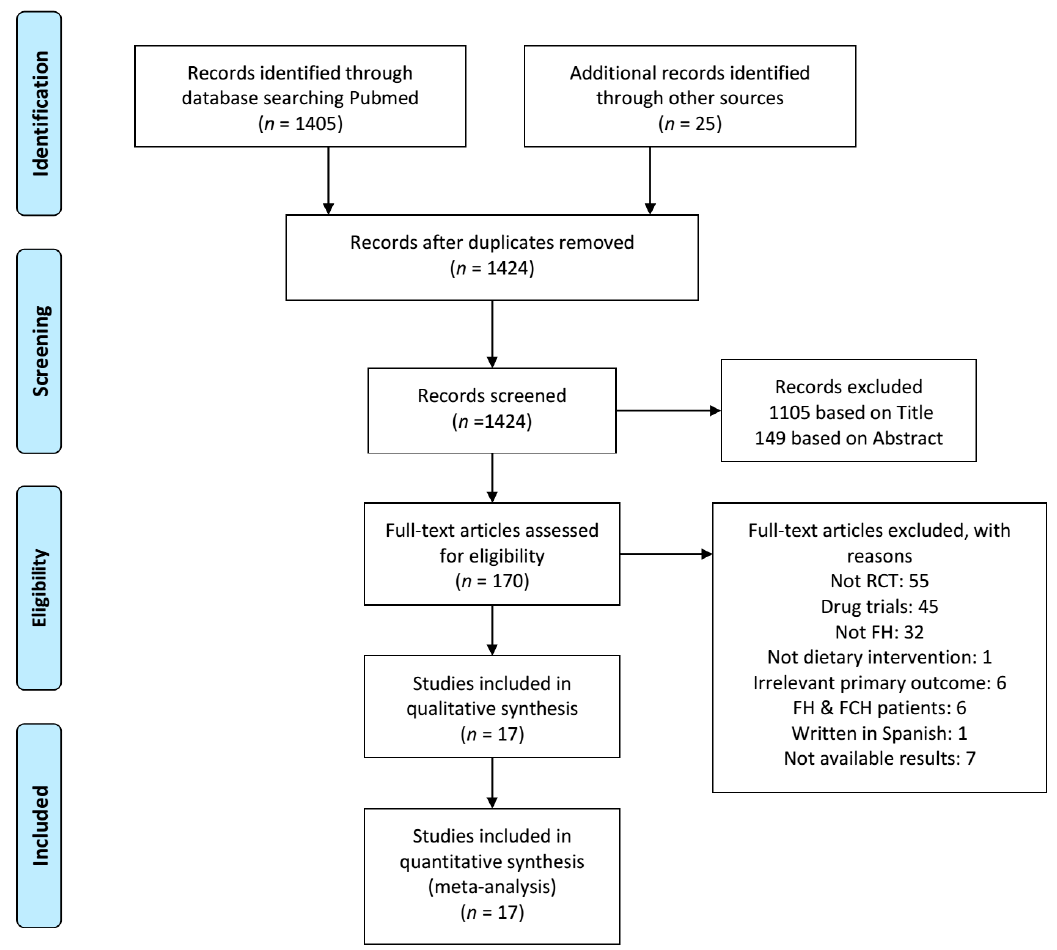
Figure 1. PRISMA flow diagram of study selection. FCH, familial combined hyperlipidemia; FH, familial hypercholesterolemia; RCT, randomized clinical trial.